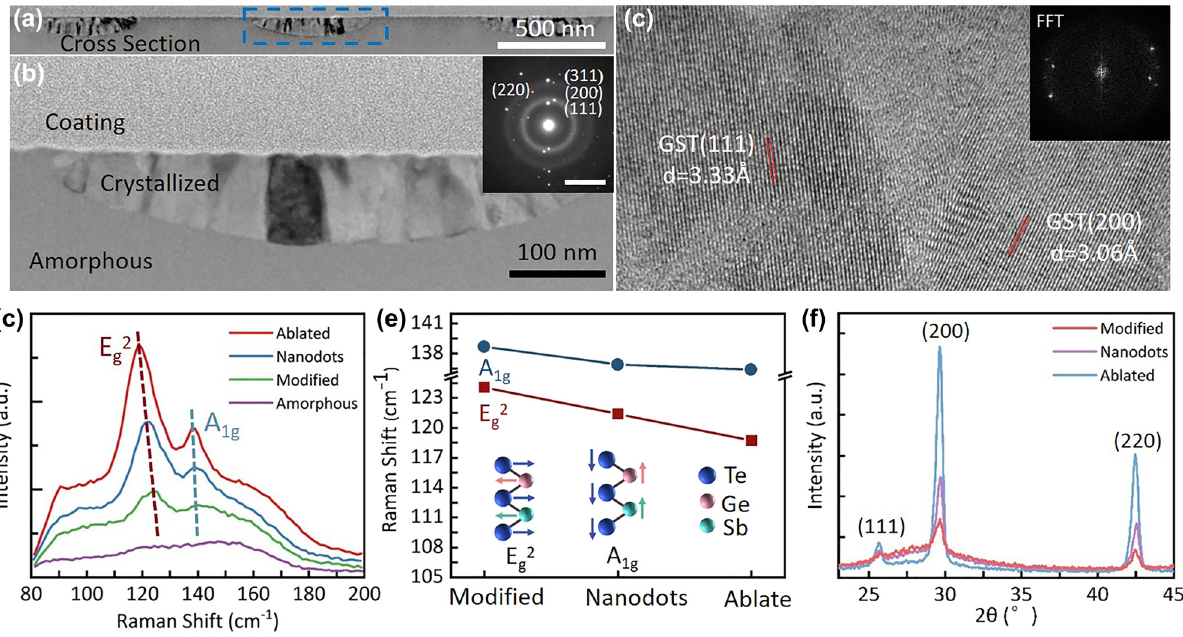
Figure 5: Analysis of the properties of the structured GST. (a) Cross-sectional TEM image of the modified ripple structure. (b) Magnified view of the blue frame marked in (a). The inset in (b) displays the selected area electron diffraction pattern of crystallized regions. (c) High-resolution TEM image of a crystalline–amorphous GST interface. The inset in (c) depicts the fast Fourier transform of the crystallized region. Raman spectra (d) of the initially amorphous GST film, modified ripple structure, ablated nanodots, and ablated ripple structure. (e) Plot of the Raman peak shift versus energy for different surface structures. (f) XRD spectra of the three distinct ps-laser-induced surface structures, which is correspond to Figure